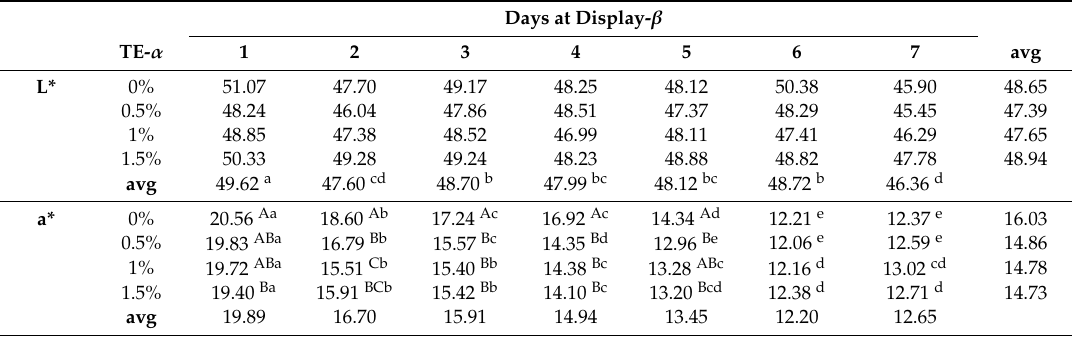
Table 2. E ff ect of tannin extract (TE) inclusion and days at display on color parameters of beef patties (avg = average of TE level or day of retail display). Days at Display-